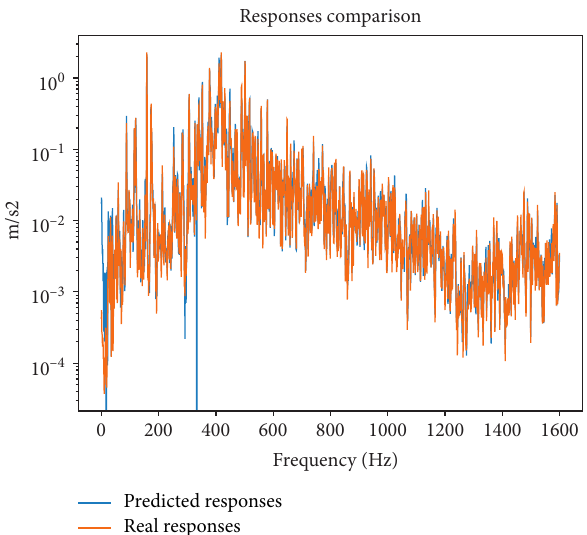
Figure 14: Comparison of predicted and real responses power spectra for the 2 nd response measurement point of the 8 th round before elastic-net regularization.